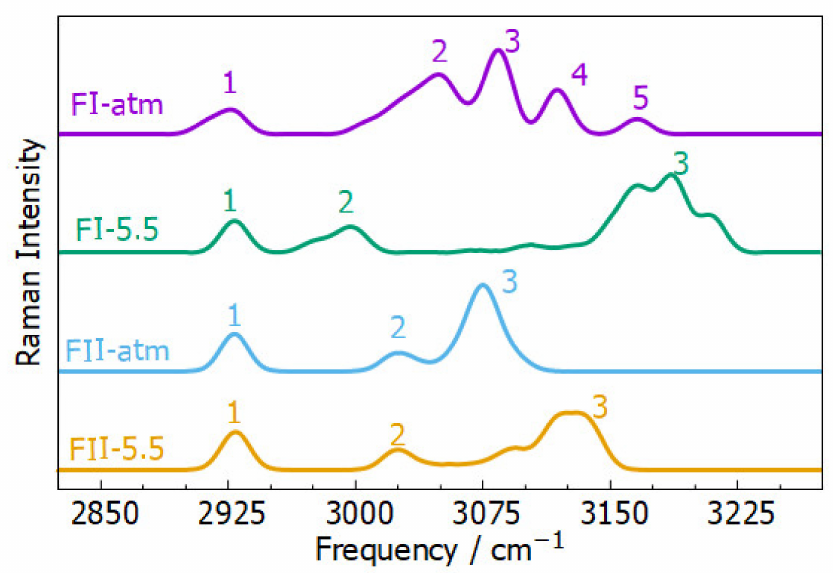
Figure 6. Calculated Raman spectra of triclabendazole form I and form II. The purple and blue curves show form I and form II at atmospheric pressure, whereas green and yellow curves show forms I and II at 5.5 GPa external